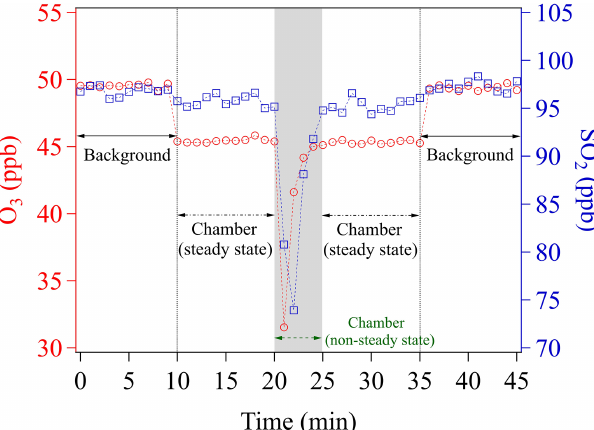
Figure 3. Time course of O 3 and SO 2 mixing ratios while plac- ing an empty sample petri dish into the chamber. The time span of the gray shaded area corresponds to the chamber equilibrium time, which is omitted in any data